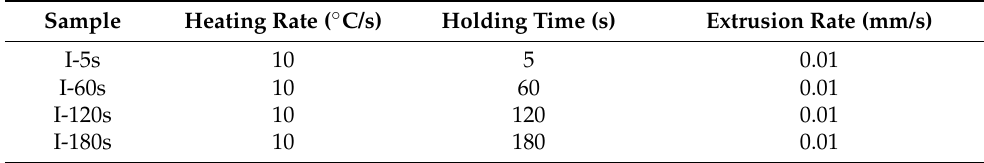
Table 2. Extrusion parameters for each holding